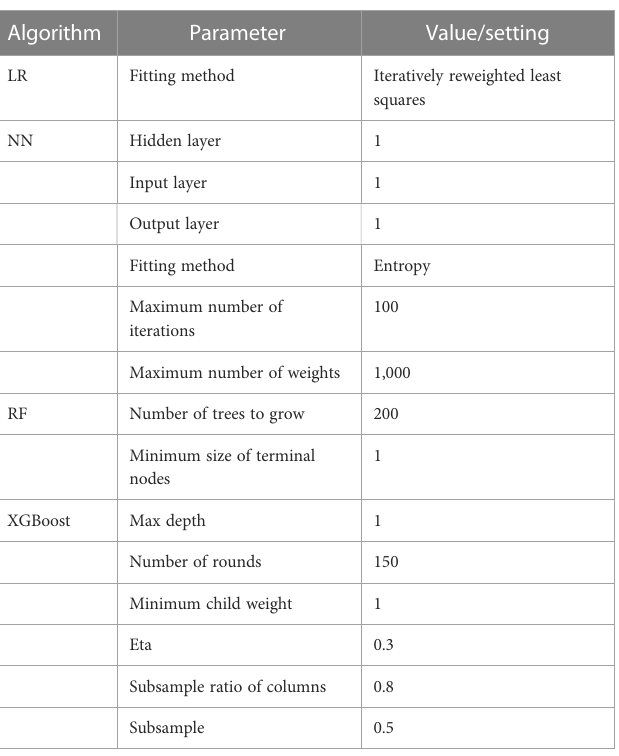
TABLE 1 Sociodemographic and clinical factors. TABLE 2 Parameter values of the four applied ML algorithms.